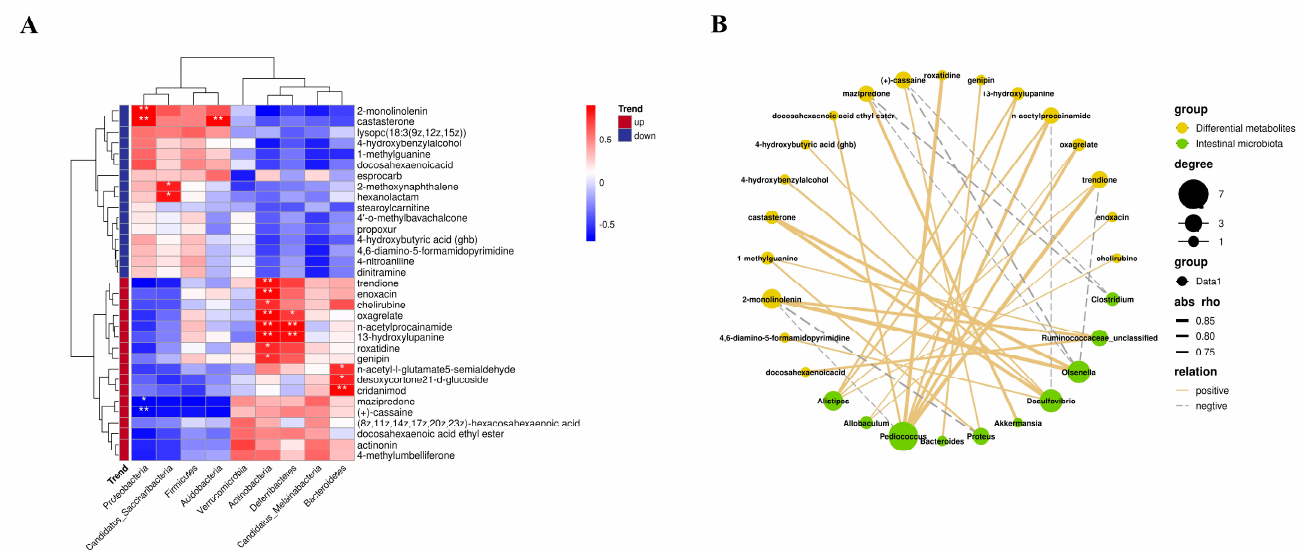
Figure 5. ( A ) The correlation between intestinal microbiota at phylum and differential metabolites between the CD group and FCF group * p < 0.05, ** p < 0.01, compared with the CD group. ( B ) Network diagram of intestinal differential metabolites and microbiota at the genus levels.